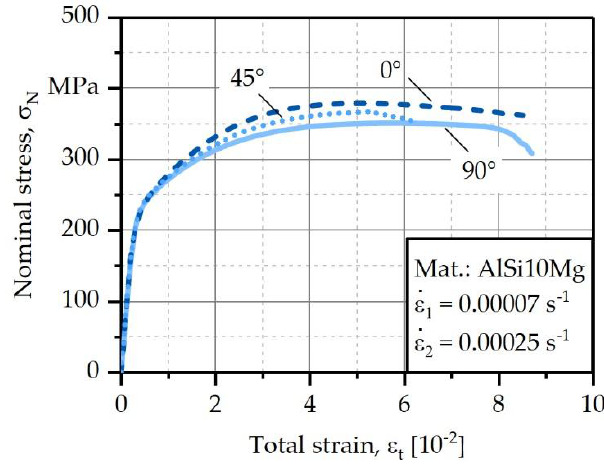
Figure 6. Relative frequency of sphericity for the AlSi10Mg building orientations 0 ◦ , 45 ◦ , and 90 ◦ .